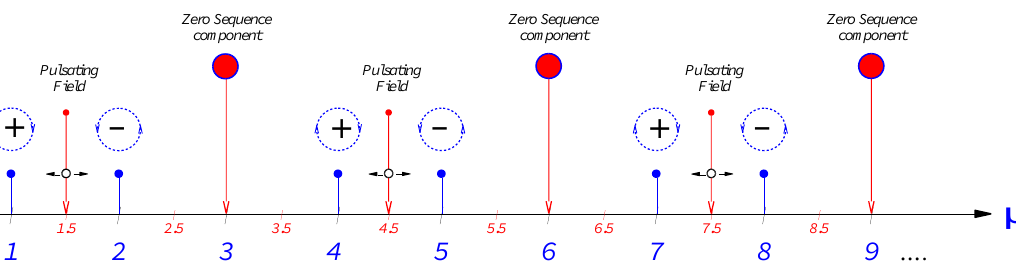
ff ect demonstration in three-phase machines. Energies 2020 , 13 , x FOR PEER REVIEW